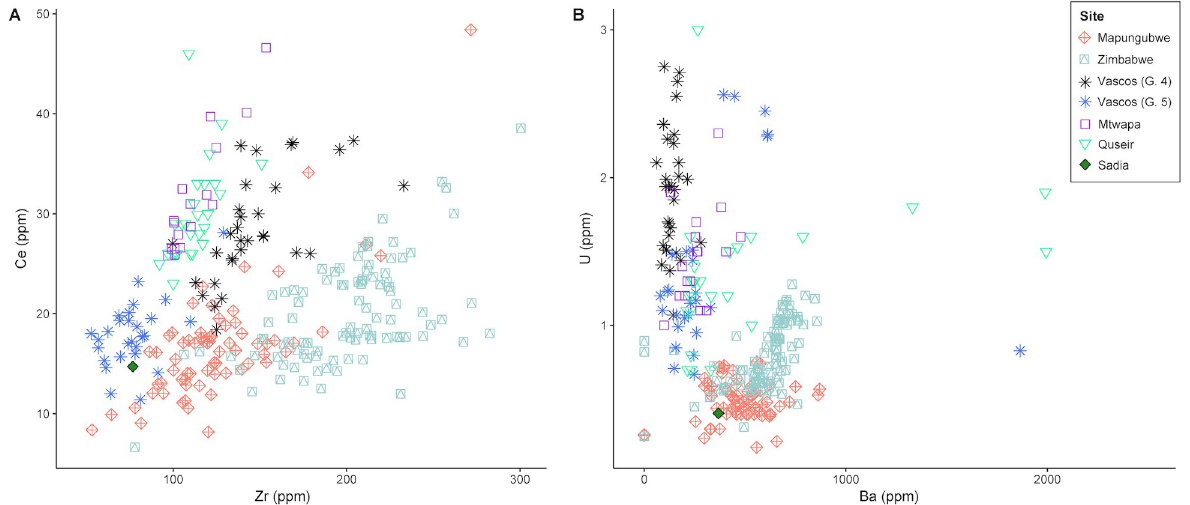
Fig 15. Trace element composition of the Sadia bead compared to contemporary high alumina glasses. Cerium versus zirconium (A) and uranium versus barium (B) of the Sadia bead compared to Iberian, southern, and eastern African glasses show compatibility with group 5 glass from Ciudad de Vascos and with South African Mapungubwe Oblate.